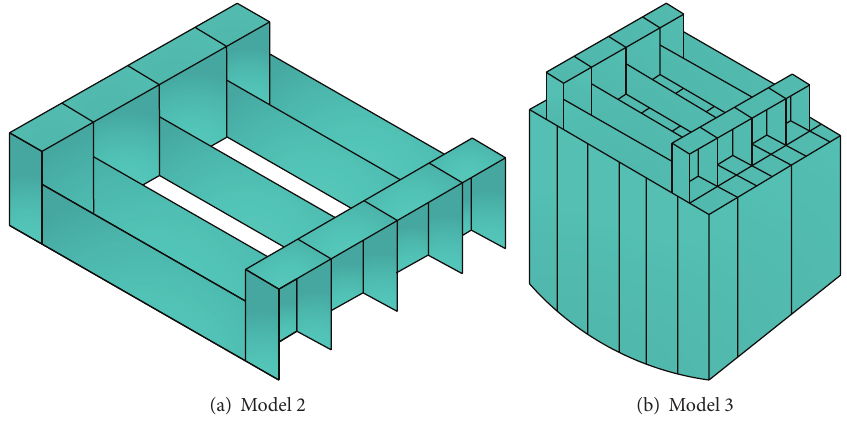
Figure 7: Illustration of Model 1.